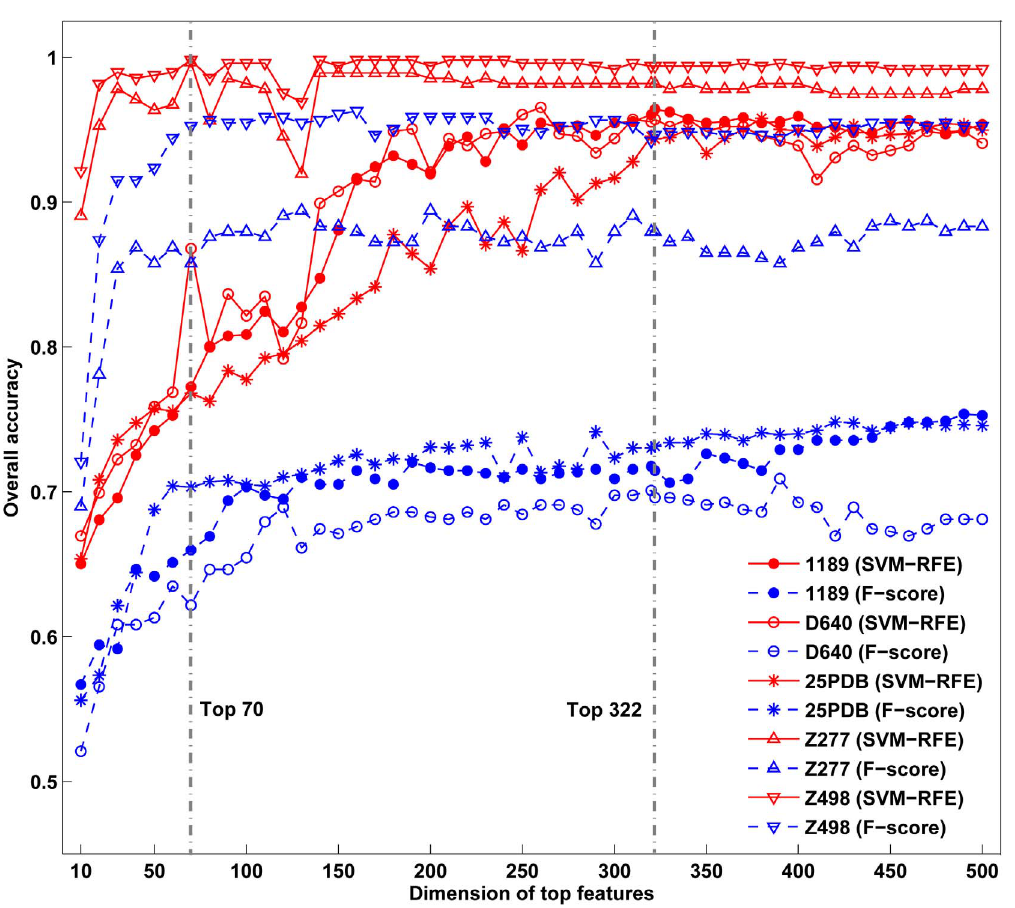
Figure 3. This graph shows comparison of prediction accuracies by SVM-RFE and F-score. Gray dotted lines highlight the selected top features for high (top 70) and low (top 322) similarity